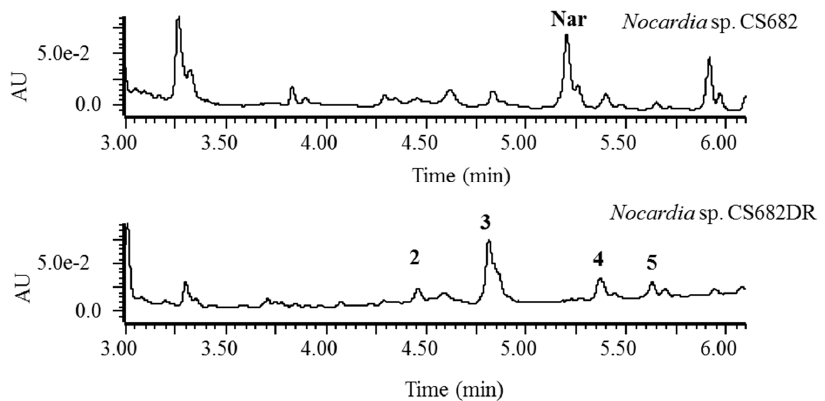
Figure 2. Ultra-pressure liquid chromatography (UPLC) chromatogram of extract from Nocardia sp. CS682 and Nocardia sp. CS682DR.